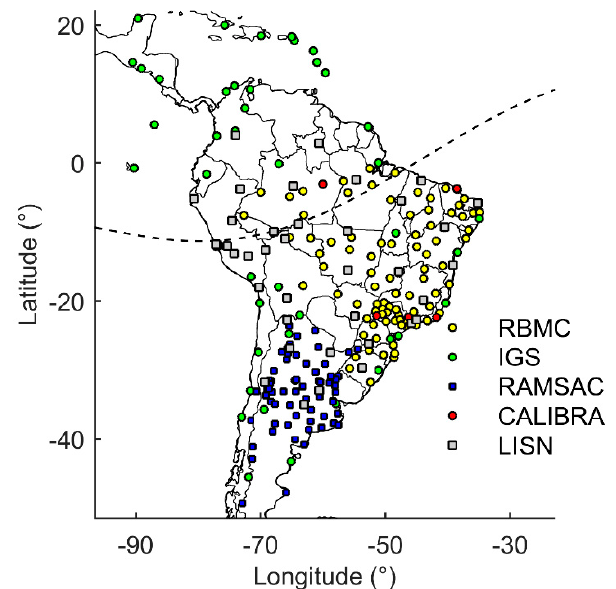
Figure 1. Global navigation satellite system (GNSS) stations operating throughout South America in Day of Year (DOY) 3 of 2014. The colored marks indicate the location of the stations for the different networks, where the dashed line shows the magnetic equator.